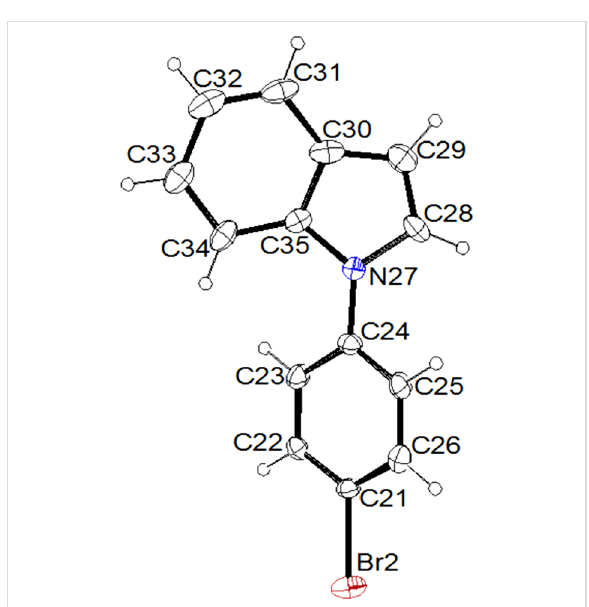
Figure 2: ORTEP diagram (30% probability) of 2e .